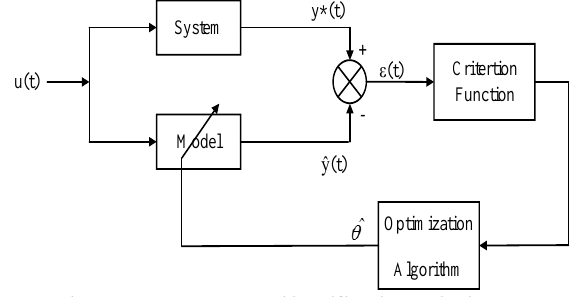
Figure 4. Output-error identification